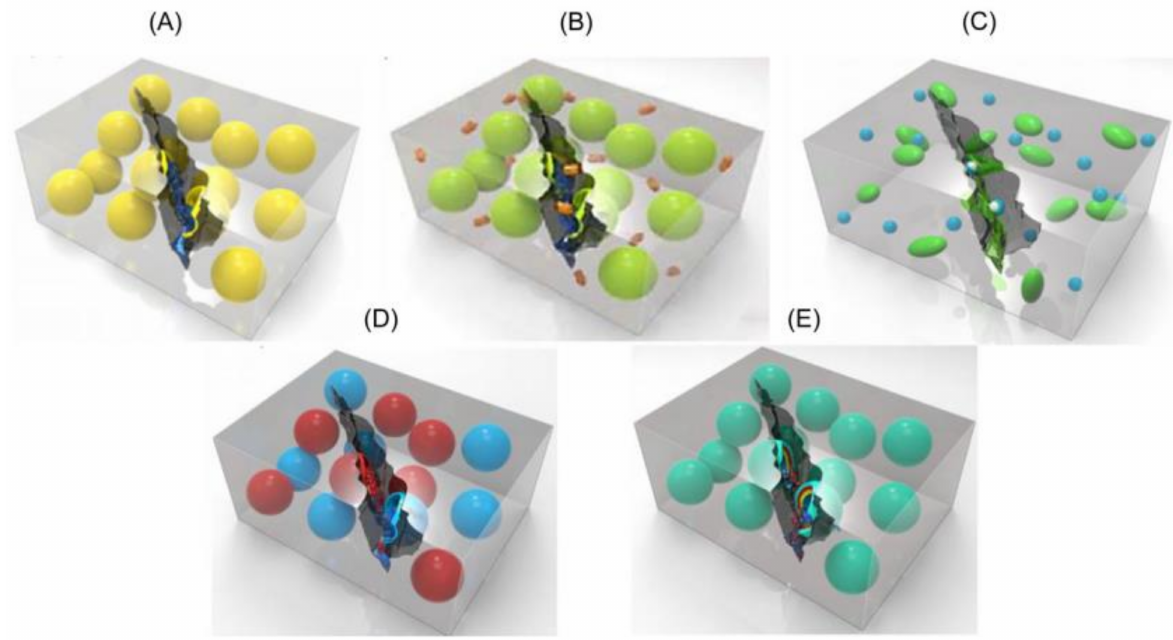
Figure 9. Capsule-based self-healing systems: ( A ) single capsules, ( B ) capsule (green)/dispersed catalyst (orange), ( C ) phase-separated droplet/capsules (green), ( D ) double-capsule (blue capsules with hardener, red capsules with healing agent) and ( E ) all-in-one microcapsules (multiple shell walls depicted with different colors) (Adapted with permission from Elsevier